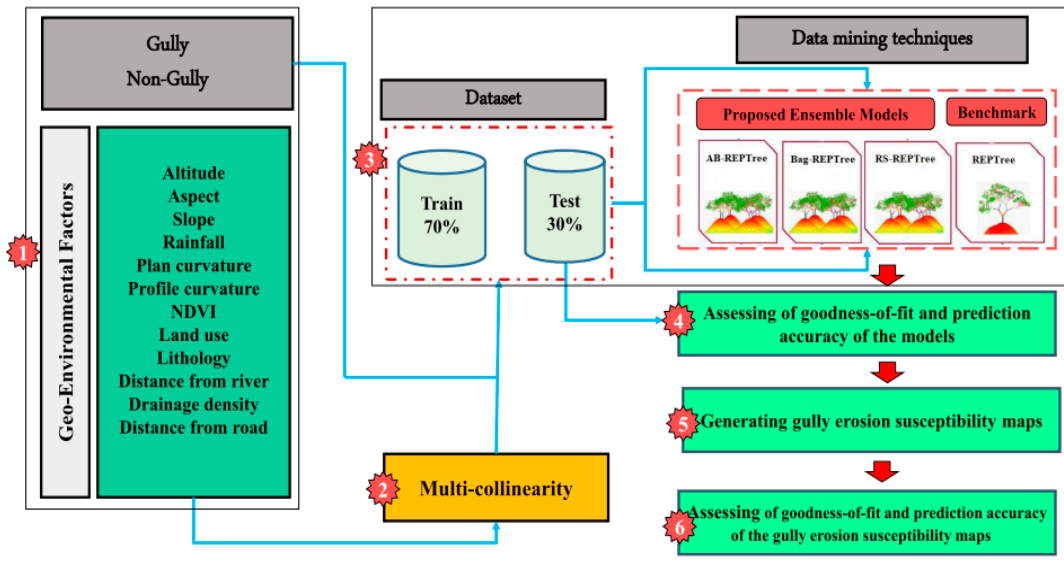
Figure 3. Flowchart of the study. 149